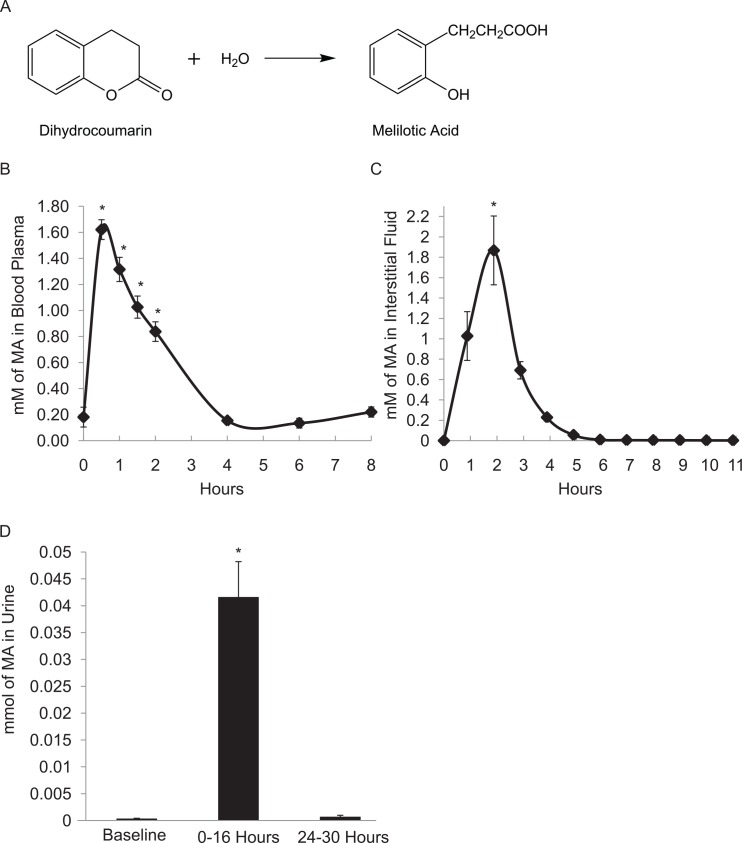
Pharmacokinetics of MA in blood plasma, interstitial fluid, and amount of MA in urine.a Scheme of conversion of DHC to MA. b MA in the plasma (AVG ± SD, n = 12) was automatically collected from the animals, centrifuged to remove red blood cells, and stored at -80°C until extraction and HPLC analysis as outlined in Materials and methods. c The interstitial fluid (AVG ± SE, n = 12) was also automatically collected from the animals and stored at -80°C until direct analysis (without extraction) by HPLC. d Urine (AVG ± SE, n = 11) was collected from the rats before gavage, 0–16 hr after gavage, and 24–30 hr after gavage. Particulates were removed from the urine by centrifugation and stored at -80°C prior to extraction and analysis as in Fig 7. * Indicates a significant difference relative to other time points for all experiments.